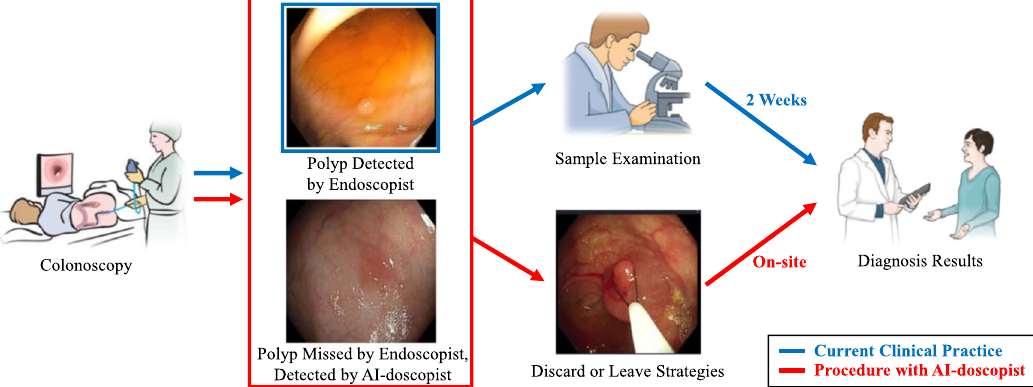
Fig. 1 An illustration of the future use of AI-doscopist, a.k.a. “ Arti fi cial Intelligent Endoscopist ” , during colonoscopy. Colonoscopy can effectively reduce CRC incidence and mortality, but is contingent on a high-quality examination. Polyps that are diminutive in size (<5 mm), sessile in type and fl at in shape are more frequently being missed during colonoscopy. To maximize the quality of colonoscopy, an automated tool is designed to assist endoscopists by highlighting regions of a possible polyp during colonoscopy.